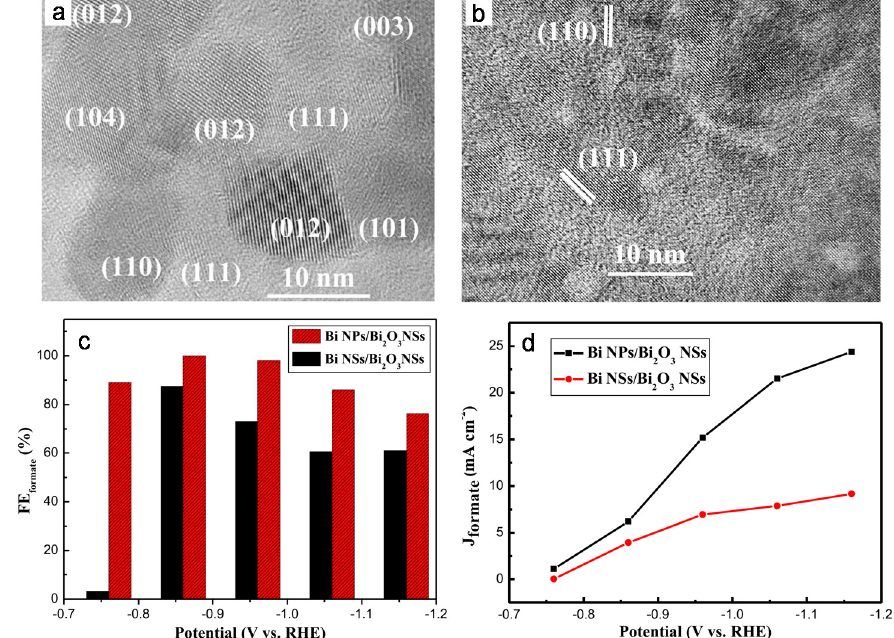
Figure 5. High-resolution transmission electron microscopy (HRTEM) images of ( a ) high-grain- boundary (GB)-density Bi NPs/Bi 2 O 3 NSs and ( b ) low-GB-density Bi NSs/Bi 2 O 3 NSs. ( c ) FE HCOOH and ( d ) formate partial current density of Bi NPs/Bi 2 O 3 NSs and Bi NSs/Bi 2 O 3 NSs. [61] Copyright 2019, Elsevier.